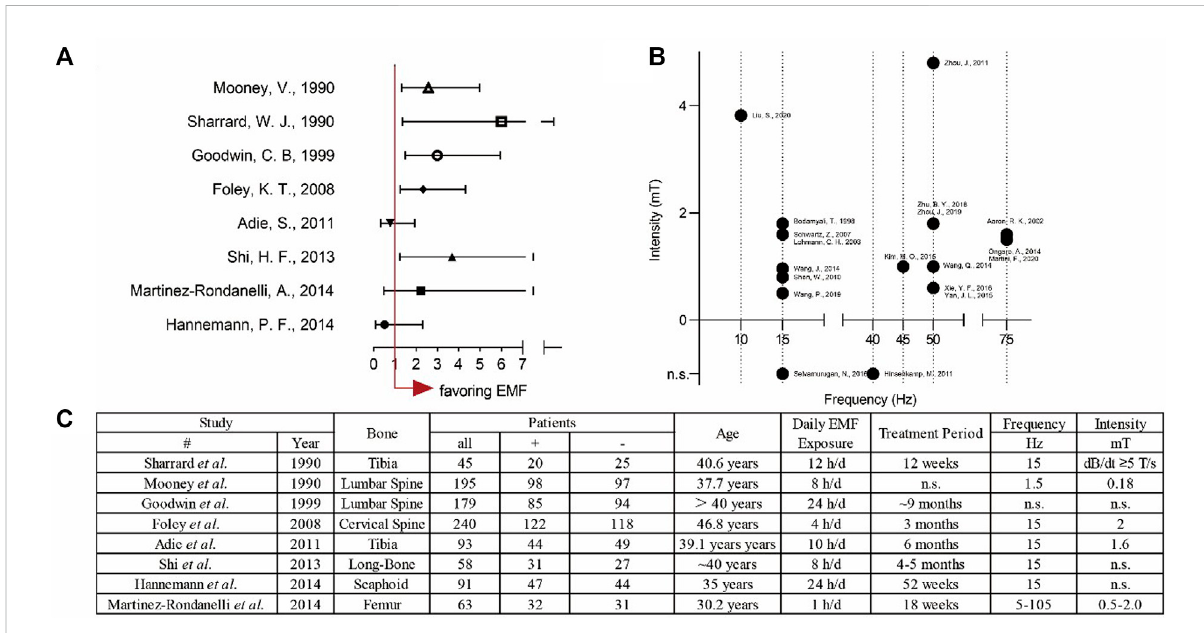
FIGURE 5 Overview of both clinical and experimental applications of EMFs. (A) Forest plot for analysing the clinical treatment of EMFs with odds ratio (OR) ± 95% con fi dence interval (B) Scatter plot for summarising the parameters used in the basic experiments. (C) The detailed data for the clinical application of